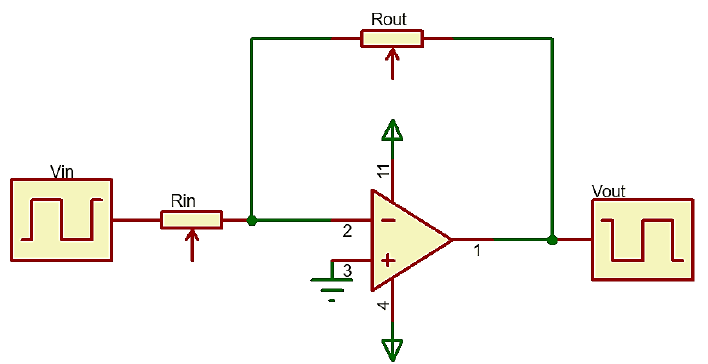
Figure 11. Inverting Amplifier Schematic.